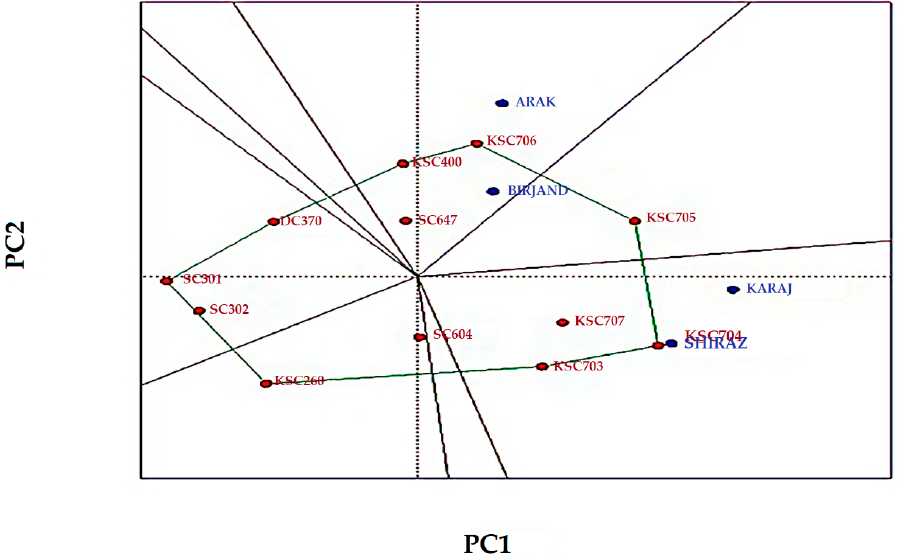
Figure 2. Polygons of GGE biplot method to determine the appropriate cultivars in every environment. The ideal hybrid is the genotype with the best mean performance and stability in all test environments. The ideal hybrids are presented at the center of a multilayered concentric circle, and the genotype under evaluation is judged based on its distance from the ideal hybrid. Genotypes near the center of the concentric circle have a good yield, and those far from the circle’s center have lower yields [33]. According to the findings, the method of hybrids arrangement in descending order is as follows: